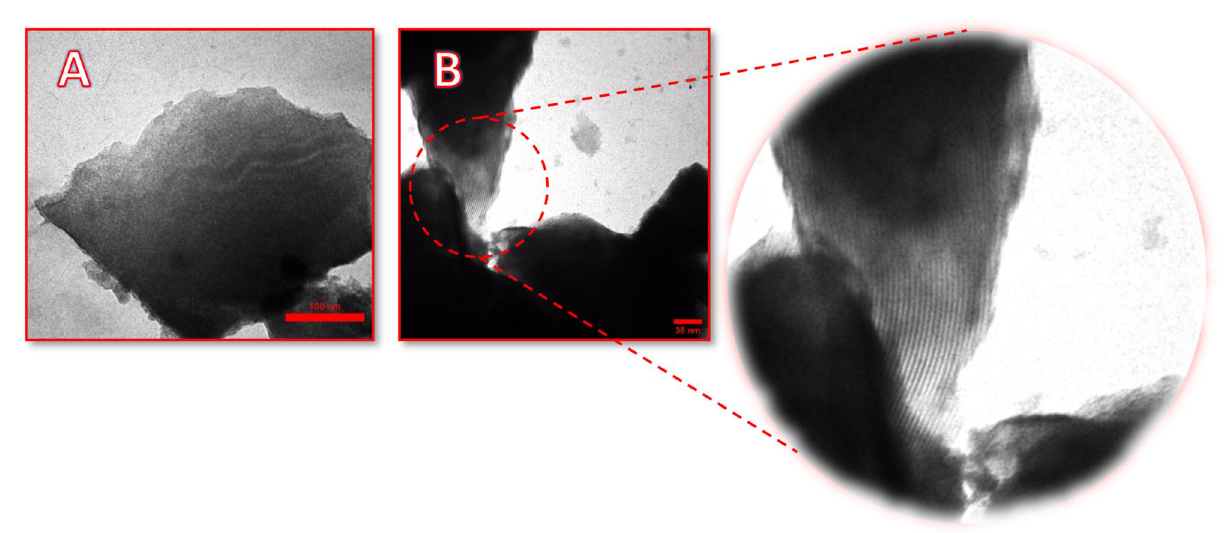
Figure 4. TEM images of Cu@MCM-41-HPr-Met